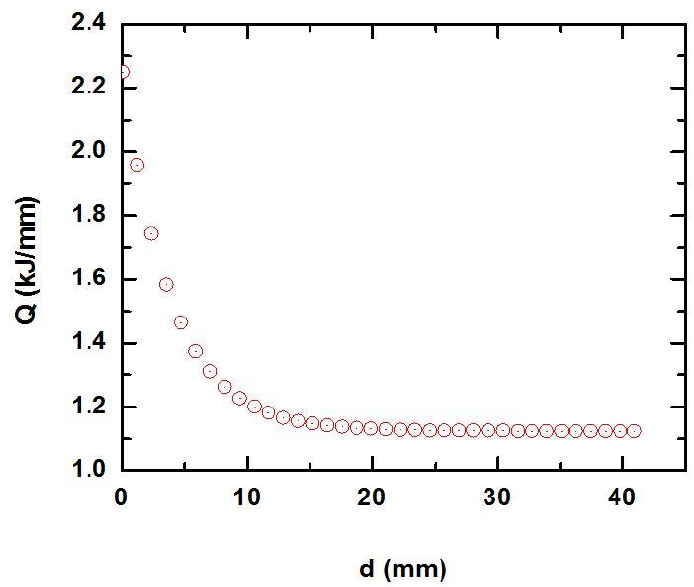
Figure 1. Dependence of the heat input values on the distance to the substrate.